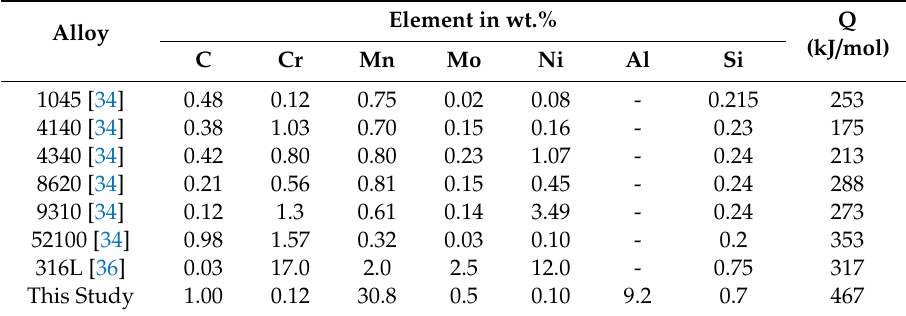
Table 3. Reported alloys and their measured activation energy for grain growth. Element in wt.% Alloy